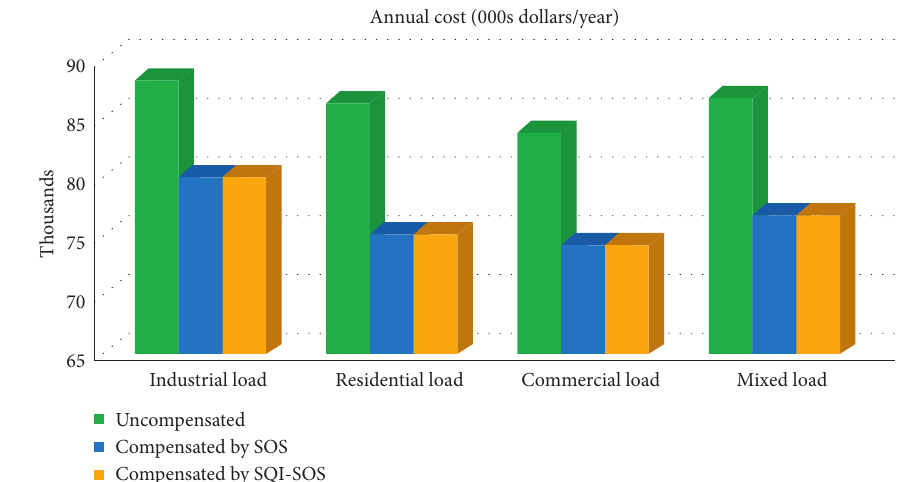
Figure 5: Annual cost of the 33-bus system before and after compensation with different load